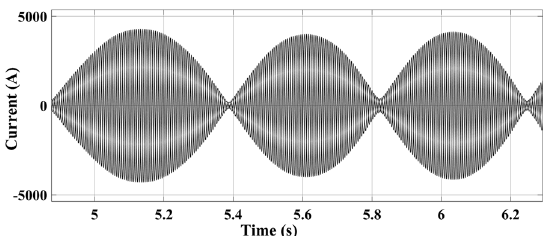
Fig. 2 Three-phase current waveform during unstable power swing